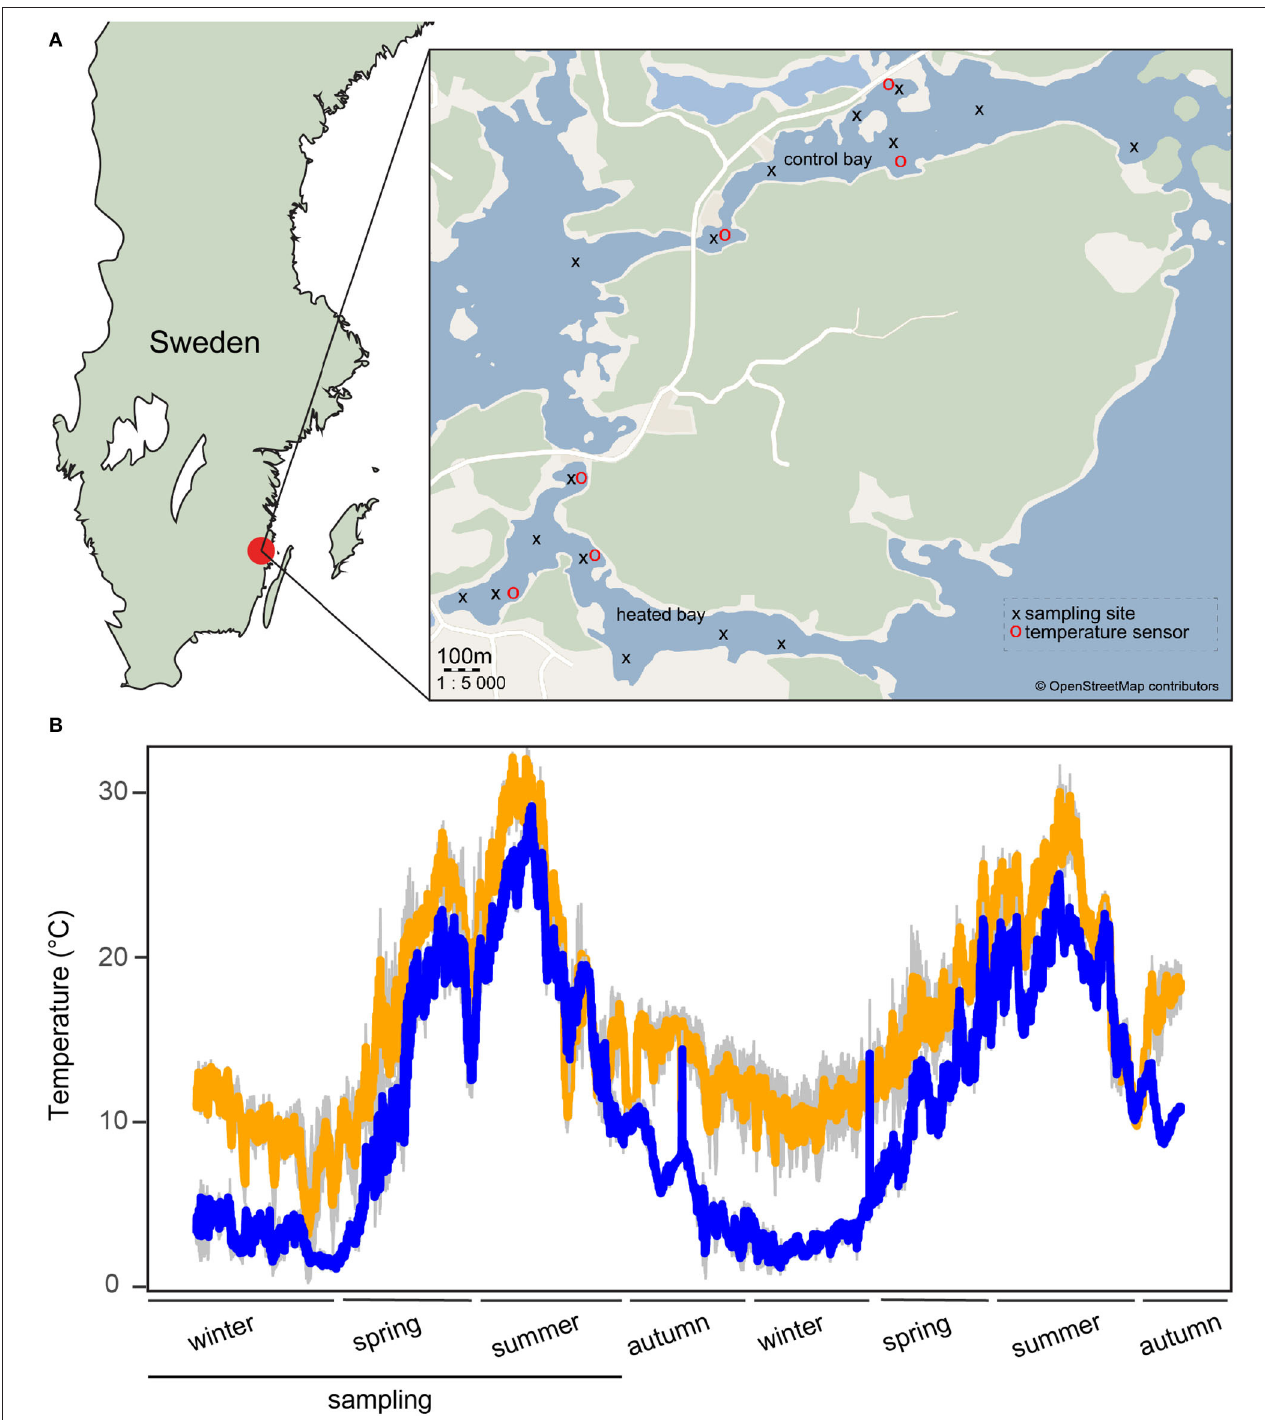
FIGURE 1 | Sampling locations and temperature tracking. (A) A modified map from Seidel et al. (2022) of the sampling area in southern Sweden. Shown are the heated bay (south) and the control bay (north) with sampling sites marked with black crosses and temperature sensors with red circles. (B) A modified temperature graph from Seidel et al. (2022), showing the temperature variation at three different sampling sites per bay (1m below the surface) measured from December 2017 until November 2019 at the heated bay (orange) and the control bay (blue) using HOBO data loggers. Standard deviations (both n = 3) are shown in gray. The lower black line shows the period of the present study from December 2017 to June 2018.